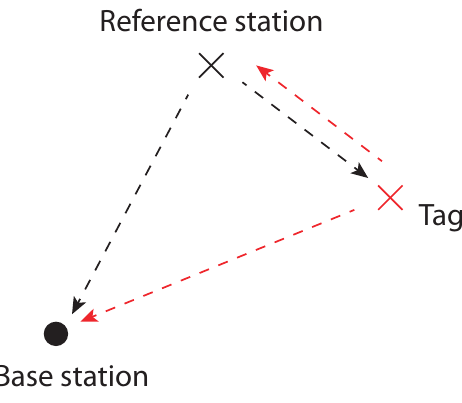
Figure 1. Transmitted messages with the DecaWave UWB system are represented by the dashed lines. The black circle is the base station, the black cross the reference station, and the red cross the tag.